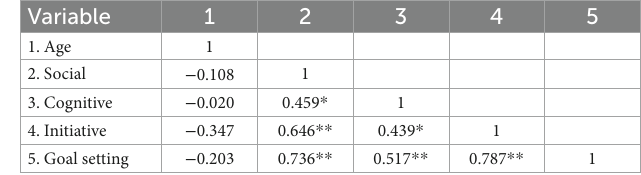
TABLE 4 Correlation matrix of age and youth entrepreneurship